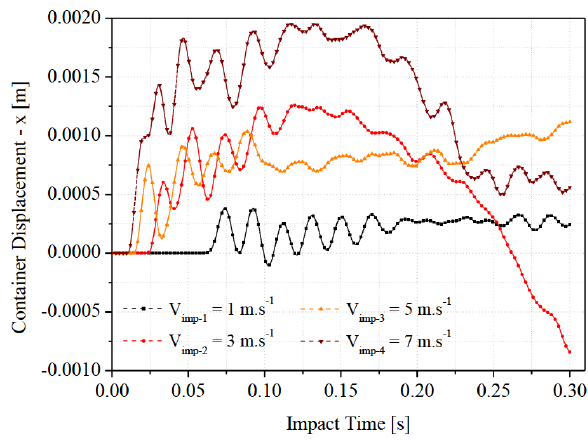
Figure 16: Container displacement on the transverse direction (y-